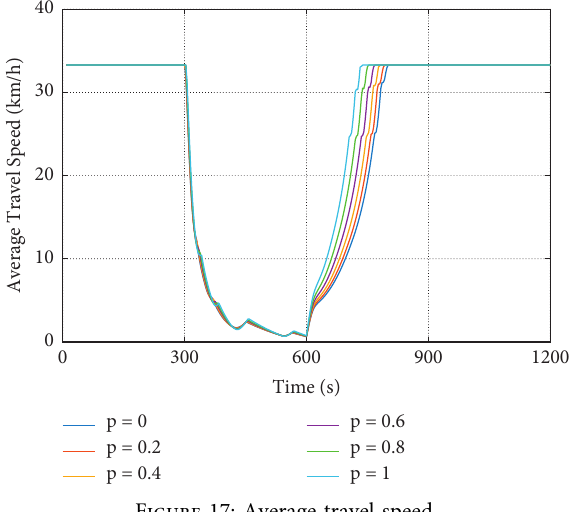
Figure 17: Average travel speed.